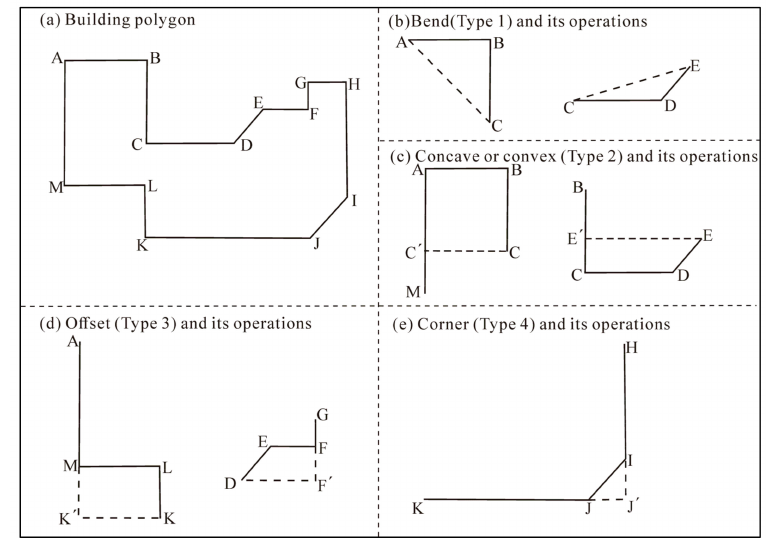
Figure 4. Local structure classifications and their basic operations (denoted by the dashed lines). ( a ) Building polygon; ( b ) bends; ( c ) concave and convex bends; ( d ) offsets; ( e ) corner. (2) Local-structure-based operations to eliminate the shortest